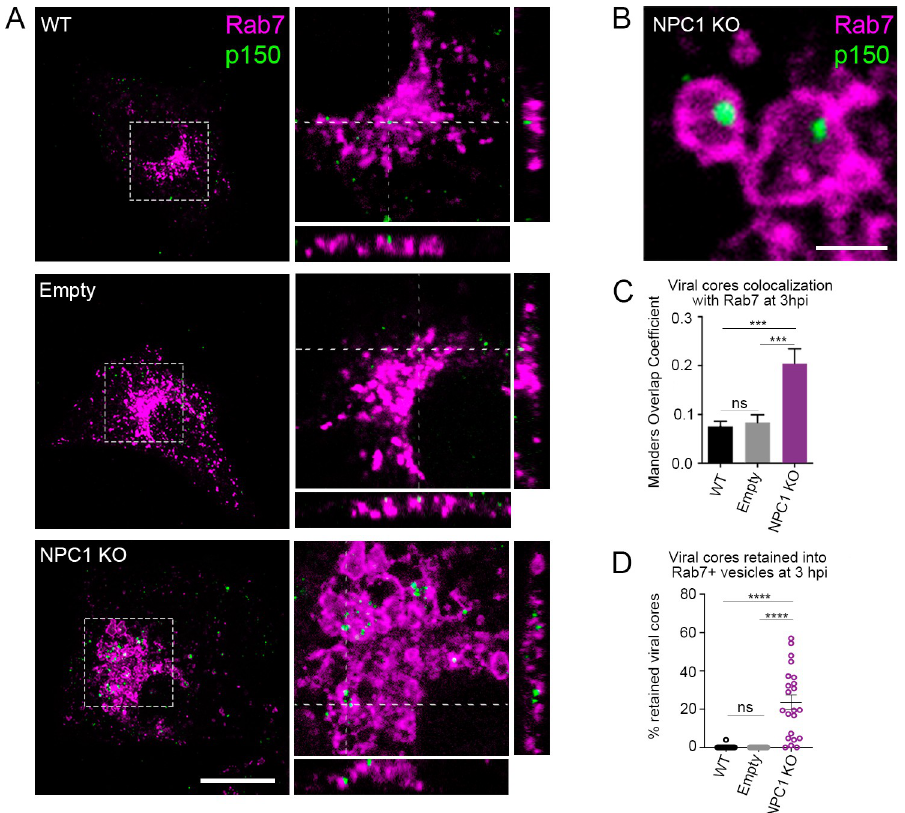
Fig 5. Viral cores visualized inside dilated late endosomes in ASFV infected NPC1 KO cells. (A) Representative micrographs of control cells (WT and Empty) and NPC1 KO cells infected at a MOI of 50 pfu/ml for 3hpi. Viral cores and late endosomes were detected with an antibody against p150 (green) and Rab7 (magenta), respectively. Orthogonal projections showed viral cores and Rab7 positive membranes in the Z stack. Note that numbers of retained viral cores were higher in NPC1 KO cells compared to controls. Scale bar: 10 μ m. (B) Insets depict endosomes containing viral cores shown in detail. Scale bar: 2 μ m. (C) Overlapping Manders coefficient (mean ± sem) from 2 independent experiments (n = ca. 25). (D) Percentages of viral cores inside endosomes (mean ± sem) from 2 independent experiments (n = ca. 25). Statistically significant differences are indicated by asterisks ( ���� p < 0.0001, ��� p < 0.001, ns-not